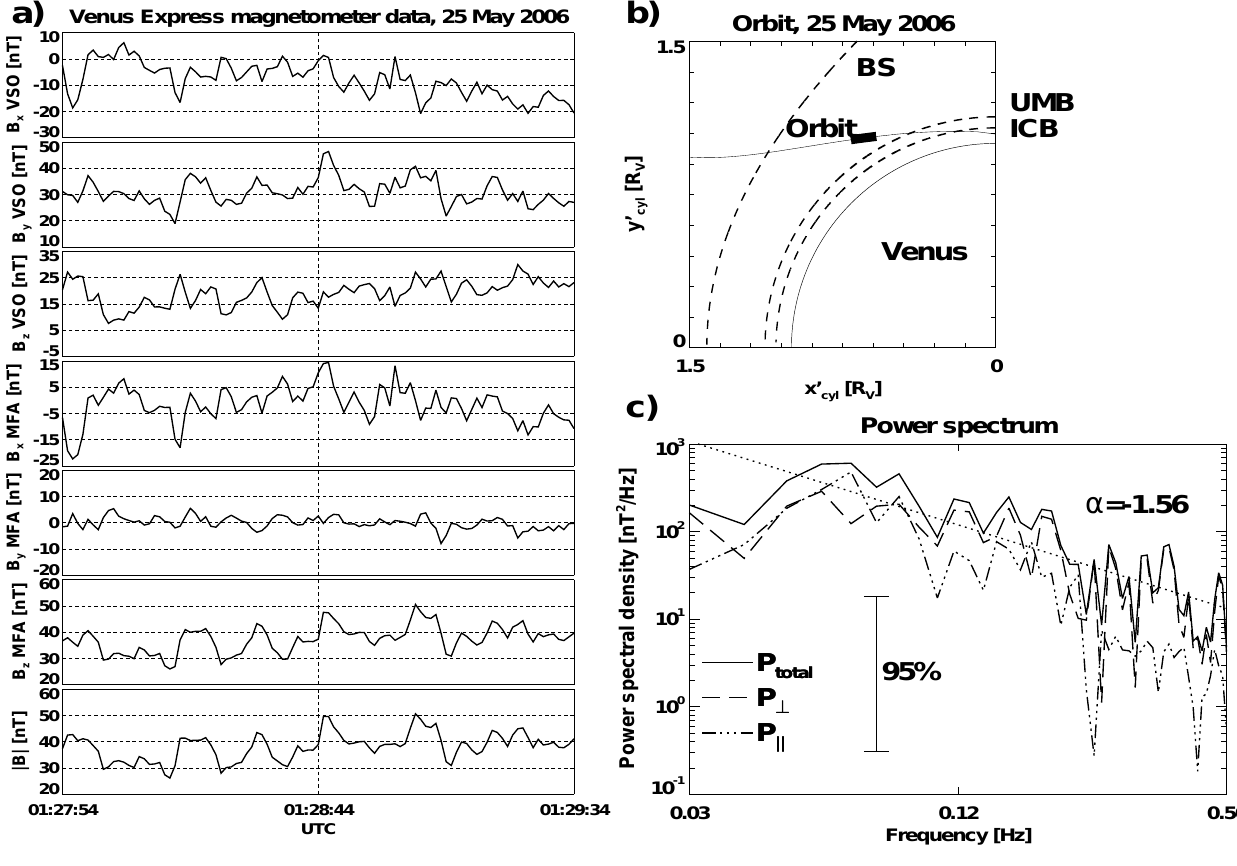
Fig. 3. Example of the analysis in the interval from 01:27:54UTC to 01:29:34UTC on 25 May 2006: (a) displays the three components of the magnetic field in VSO and MFA coordinates as well as the magnetic field strength. The mean magnetic field strength is 38nT corresponding to the proton gyrofrequency f gyro = 580mHz; (b) shows a sketch of the orbit in the dayside plasma environment close to Venus in cylindrical VSO 0 coordinates. The black rectangle denotes the analysed time interval; (c) shows the power spectra of the magnetic field data in the frequency range from 30 to 500mHz of the total power ( P total ) as well as the transverse ( P ⊥ ) and the compressional ( P k ) component (here a window function is applied to the spectra in order to increase the significance of the structures, but the spectra do not exhibit spectral peaks larger than the 95% confidence interval in this single spectrum). The dotted straight line indicates a linear fit in the logarithmic scaled spectrum revealing the spectral index α =− 1 .